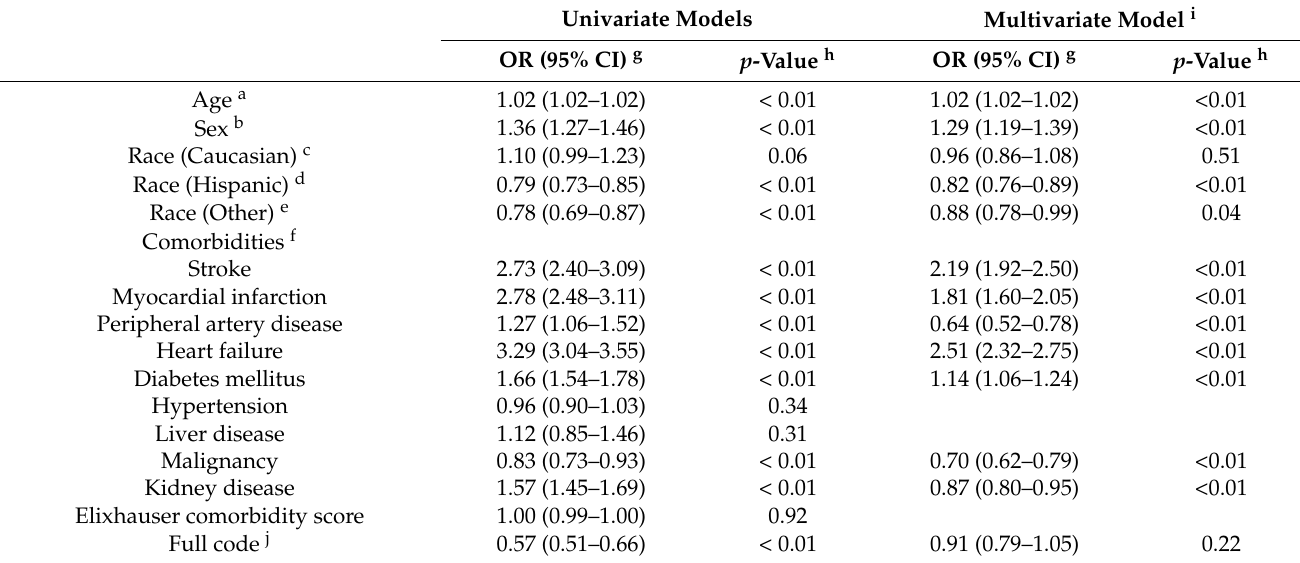
Table 2. Univariate and multivariate logistic regression for performing transthoracic